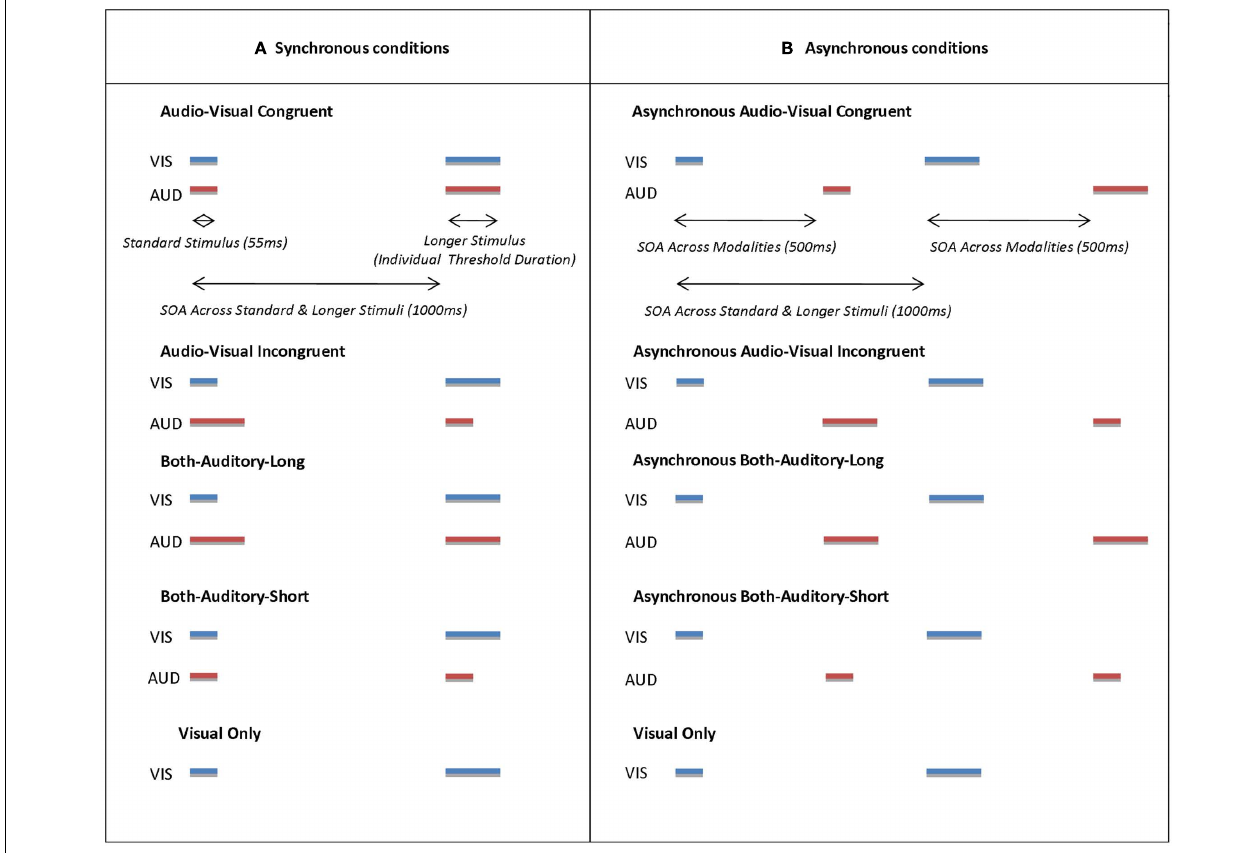
FIGURE 1 | Schematic timelines representing conditions in Experiment 1A and 1B. In Experiment 1A all corresponding auditory (red lines marked with label “AUD”) and visual (blue lines marked with label “VIS”) stimuli had the same onset (synchronous conditions) while in Experiment 1B visual stimuli always preceded auditory stimuli by 500ms (asynchronous conditions). In both situations, each pair of stimuli within one modality was